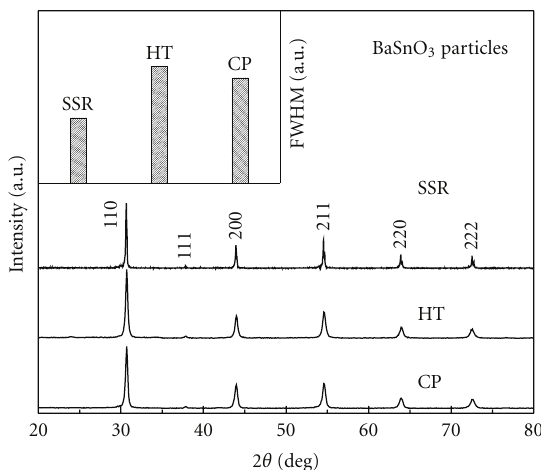
Figure 1: XRD patterns of the CP, HT, and SSR BaSnO 3 particles. The inset shows the FWHM of the three